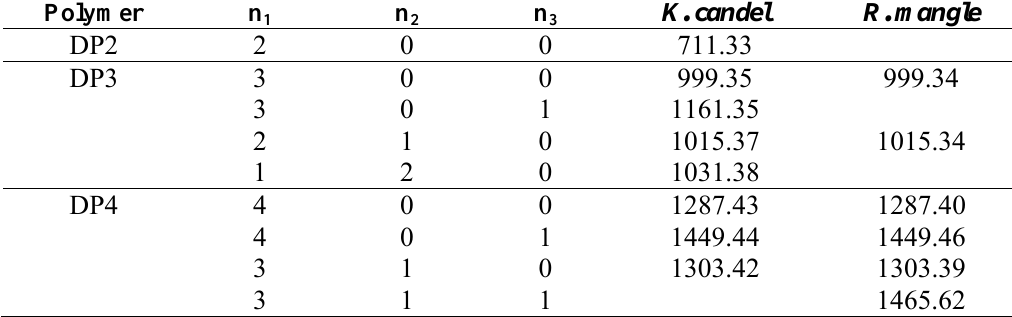
Table 2. Summary of peaks with the highest intensities in MALDI-TOF MS of the condensed tannins from K . candel and R. mangle